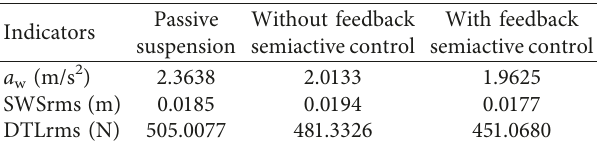
Table 2: The response root mean square values of the hybrid suspension in semiactive control.